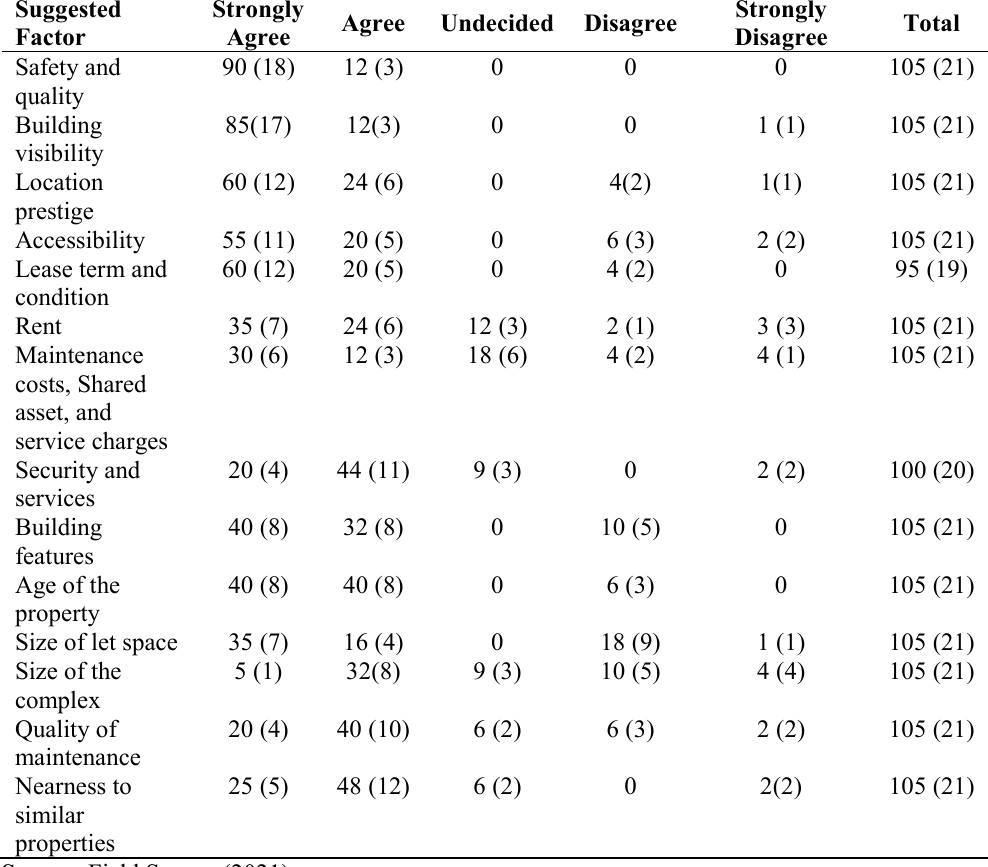
Table 5. Property Valuers’ Opinions on the Factors that Influence Rental Variation of Commercial Complexes in the Study